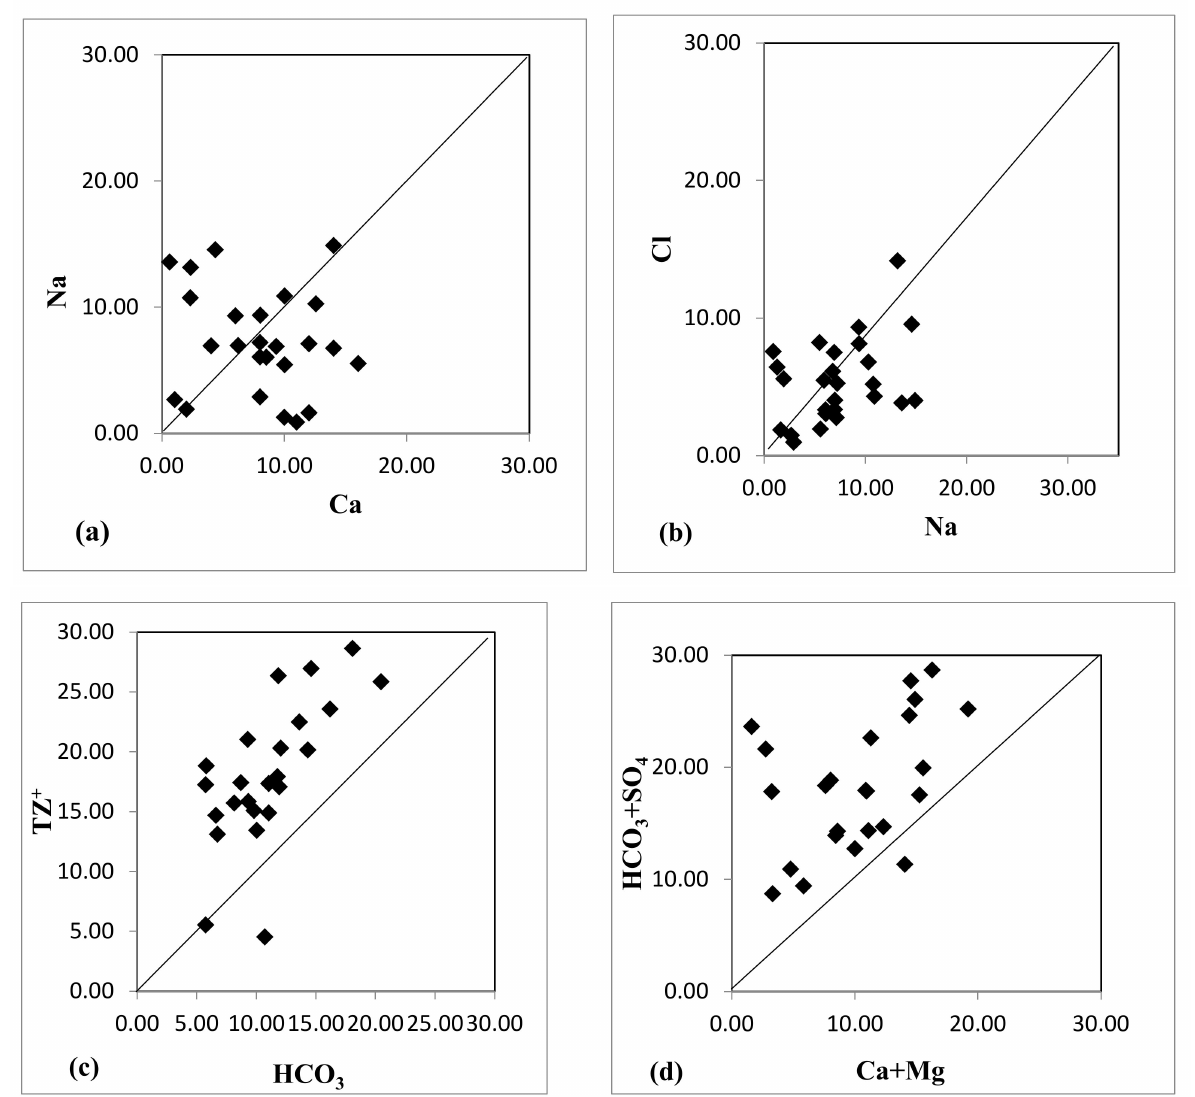
Figure 6. Scatter plot ( a ) Ca 2+ vs. Na + ( b ) Na + vs. Cl − ( c ) HCO 3 − vs. Tz + ( d ) Ca 2+ +Mg 2+ vs. HCO 3 − + SO 42 − (units of ions in